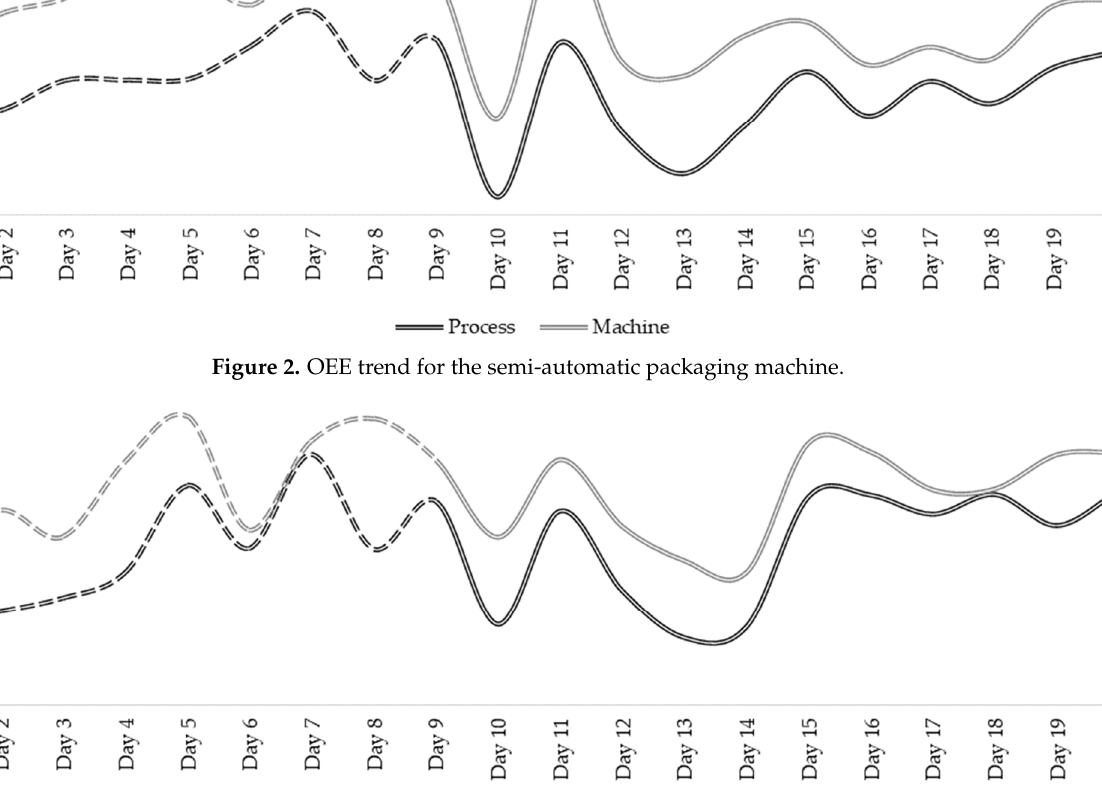
Figure 3. Operating rate/availability trend for the semi-automatic packaging machine.